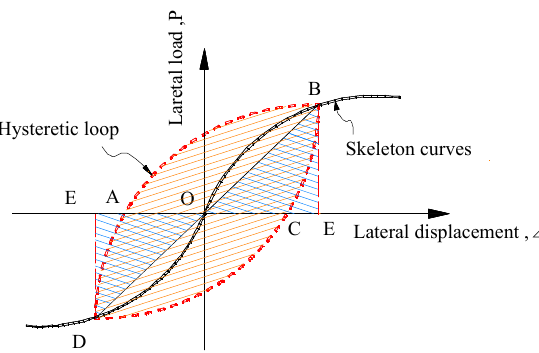
Figure 10. Calculation diagram of the equivalent damping ratio.